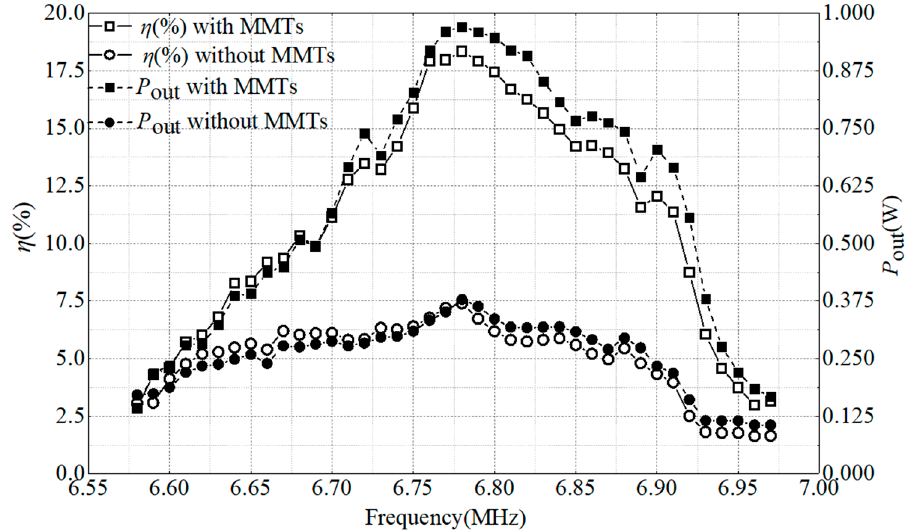
Figure 11. Variation of power and efficiency with different frequencies.